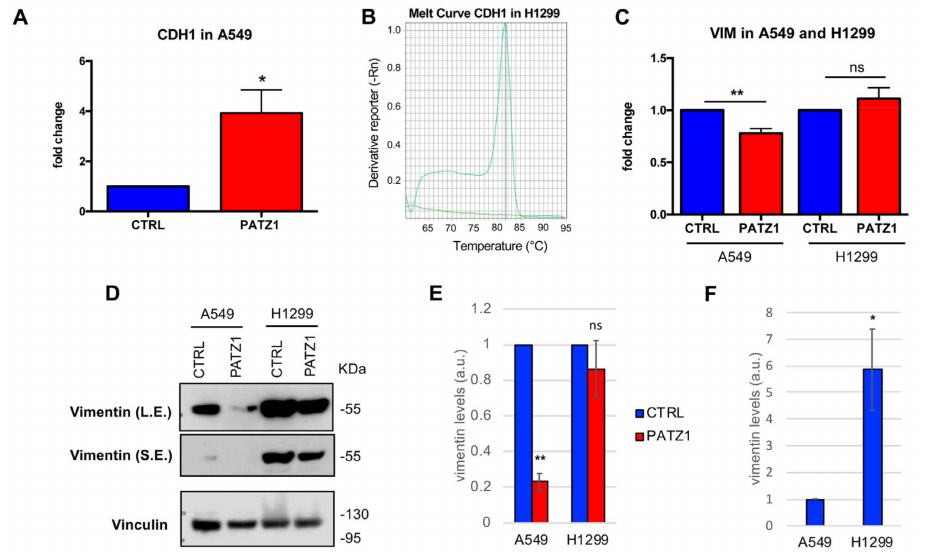
Figure 8. PATZ1 overexpression attenuates EMT in NSCLC cells. RT-qPCR ( A – C ) and Western blot ( D – F ) results in A549 and H1299 cells transfected with PATZ1-overexpressing plasmid (PATZ1) or empty vector used as control (CTRL). ( A ) Relative gene expression of CDH1 in A549 cells, as assessed by RT-qPCR. ( B ) Representative melting curves of CDH1 amplification in H1299 cells. A distinct curve (Tm = 81.66), indicative of a specific amplified transcript, was observed in PATZ1 (cyan) but not in CTRL (green) samples. Melting curves of the related actin amplification are shown in Figure S4. ( C ) Relative gene expression of VIM in A549 and H1299 cells. ( D ) Western blots using anti-vimentin on total cell extracts of A549 and H1299 cells. Vinculin was used for normalization. L.E., longer exposure; S.E., shorter exposure. ( E ) The relative levels of vimentin were quantified by Image J (v1.46r), normalized with respect to vinculin, and expressed relative to each control, arbitrarily set to 1. ( F ) The relative levels of vimentin in both control cells are shown. Mean values +/ − SE of two or three independent experiments are reported in A, C, E, F. * p < 0.05; ** p < 0.01; ns, not significant. The uncropped blots are shown in Figure S5.